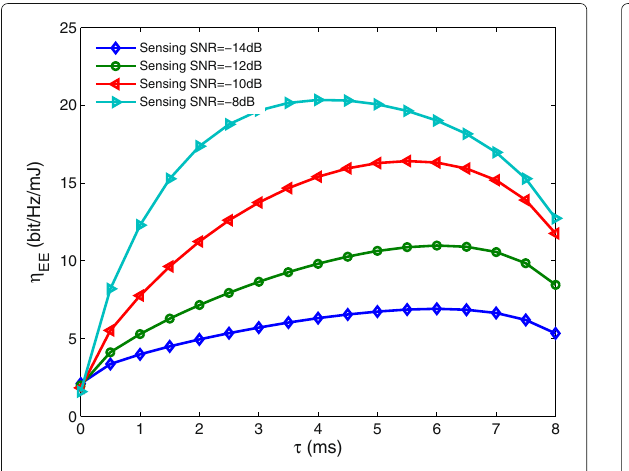
Fig. 3 Energy efficiency with sensing time